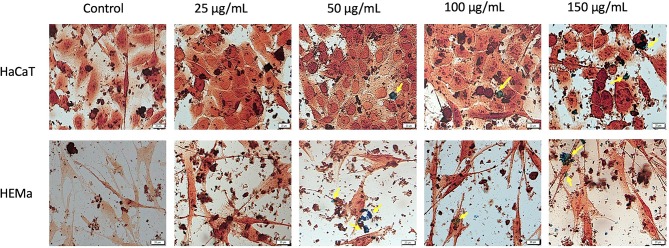
Healthy - HaCaT and HEMa cells incubated with different concentrations (25, 50, 100, and 150 µg/ml) of SCMIOPs for 24 h and stained with Prussian blue reagent. Pictures were taken using Bright field (BF) microscopy. Scale bars represent 20 µm.